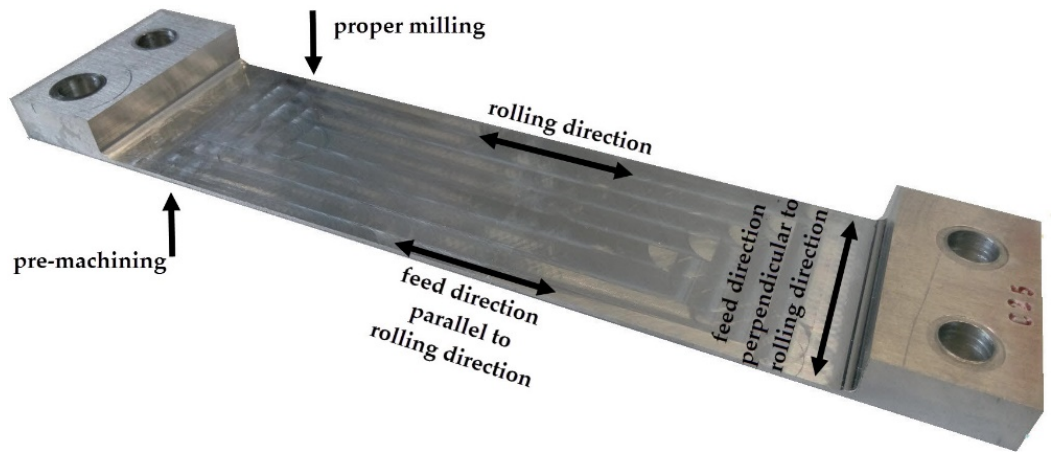
Figure 3. View of the sample with marking the relation between cutting tool feed direction and rolling direction.